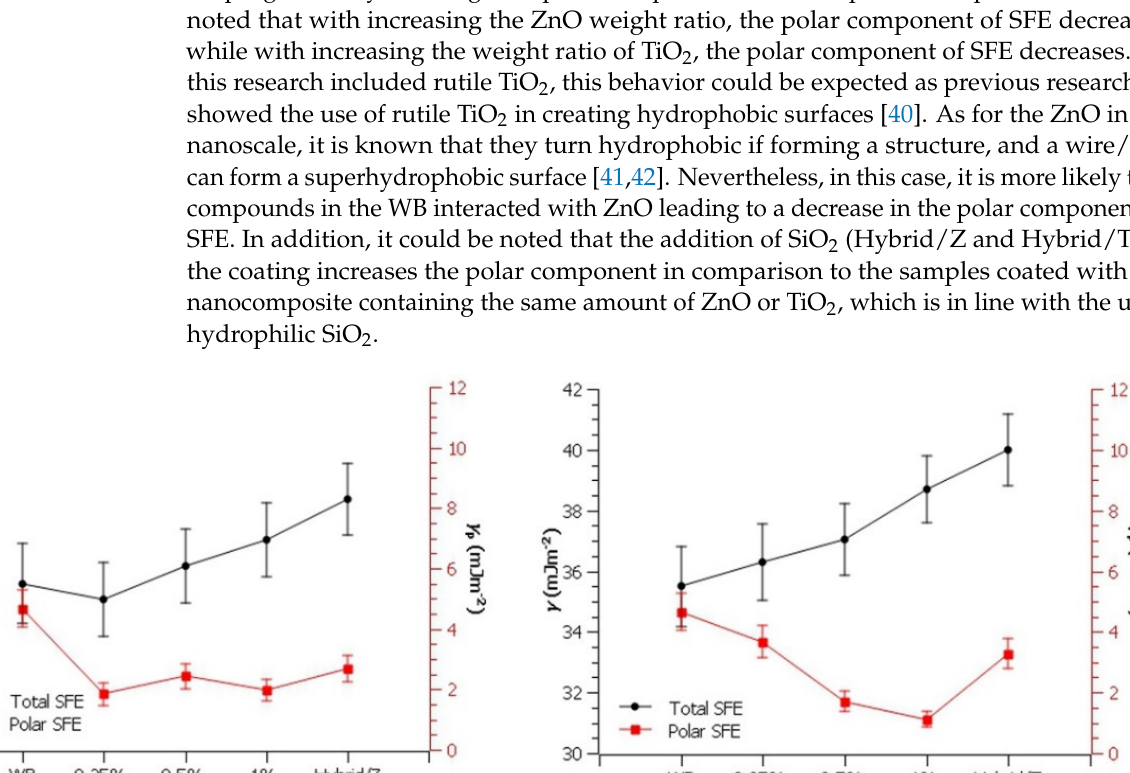
Table 3. Results of testing the growth inhibition of artificially inoculated pathogens and environ- mentally contaminated cardboard samples by nanocomposite coatings .